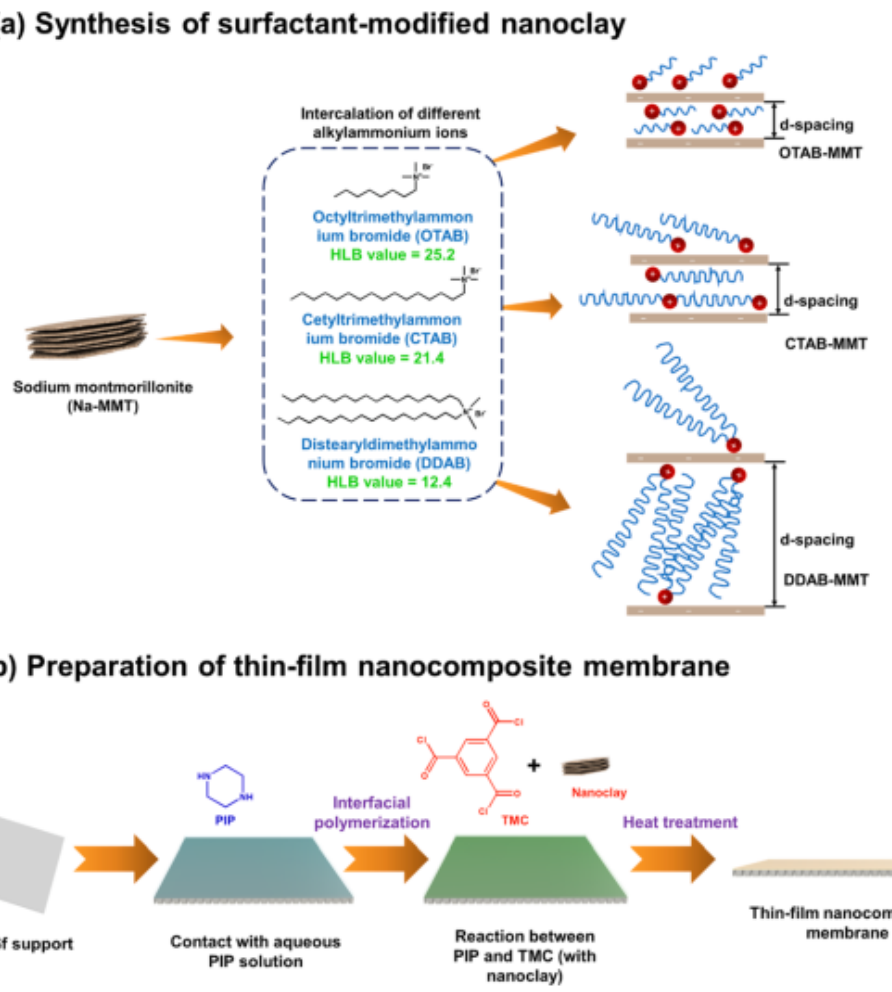
Figure 6. Illustration for ( a ) synthesis of surfactant-modified nanoclay; and ( b ) preparation of thin- film nanocomposite membrane [93]. (Copyright 2022. Reproduced with permission from Elsevier.)